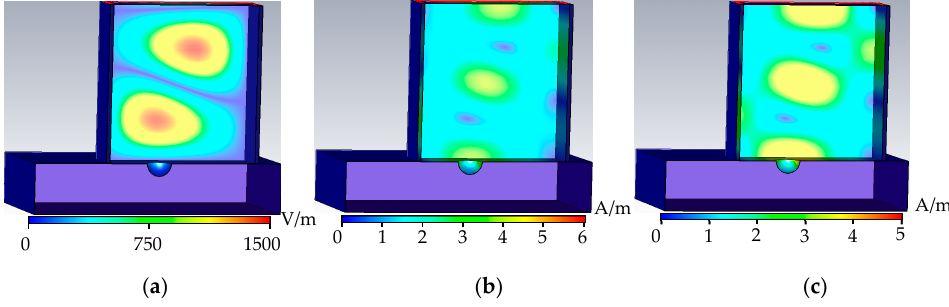
Figure 8. Hemispheric defect field distribution. ( a ) Hemispheric defectel ectric field distribution. ( b ) Hemispheric defect magnetic field distribution. ( c ) Hemispheric defect wall current